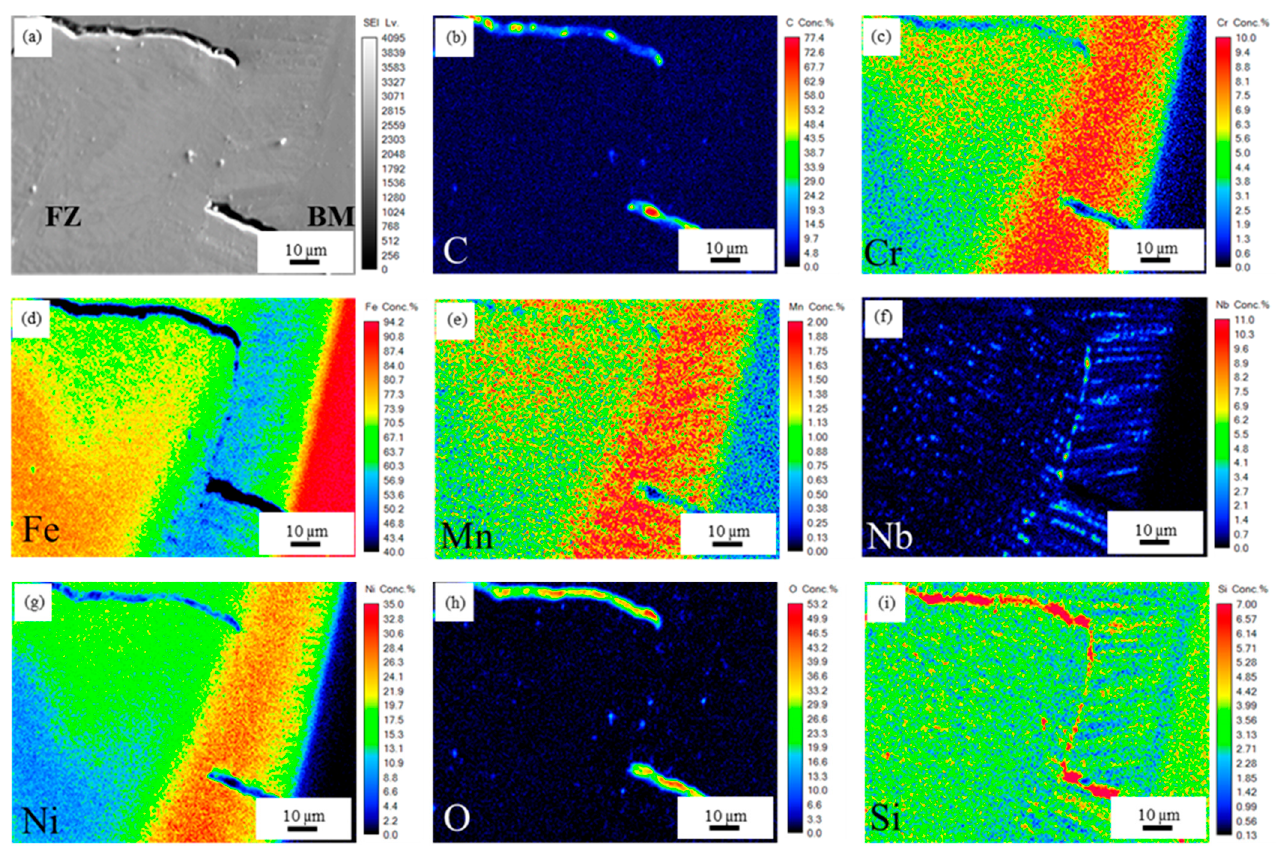
Figure 5. Selected area in Figure 4a at higher magnification: ( a ) EPMA SEI, ( b – i ) WDS quantitative mappings of C, Cr, Fe, Mn, Nb, Ni, O and Si in at%.